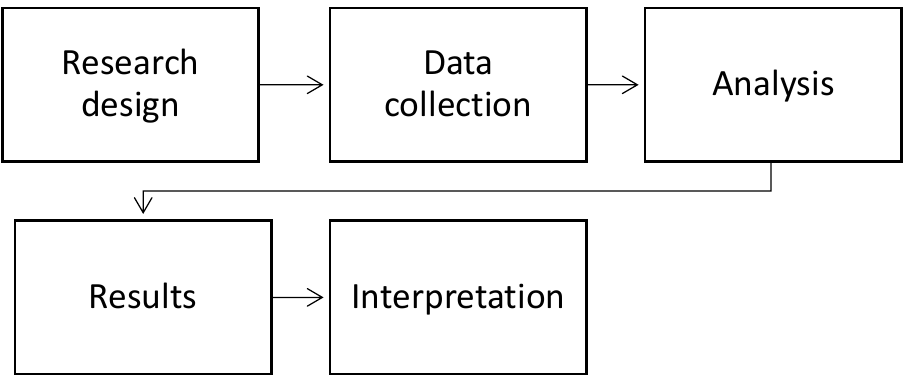
Figure 5. Research process of Q methodology [17].